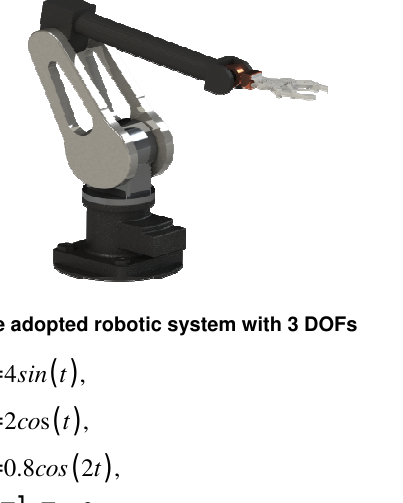
Figure 4.Final trajectory tracking – q 3 - BEA